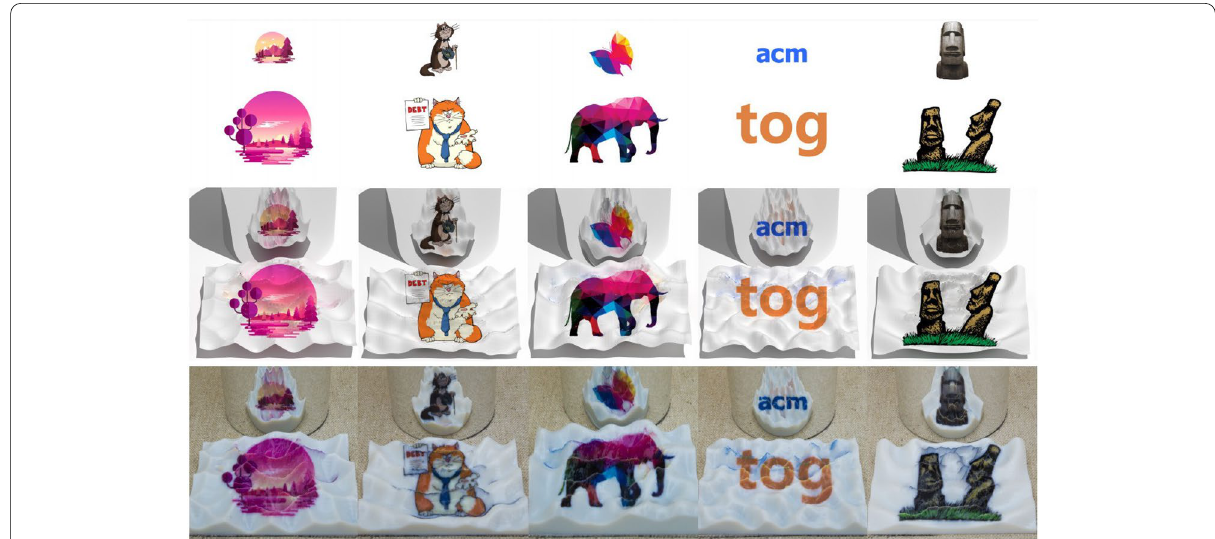
Fig. 14 Five mirror cup art pieces physically fabricated with 3D printing in ref. [25]. Their algorithm deforms the surface appropriately to eliminate the conflict area. The user can see two different images when placing the result in front of a mirror cup